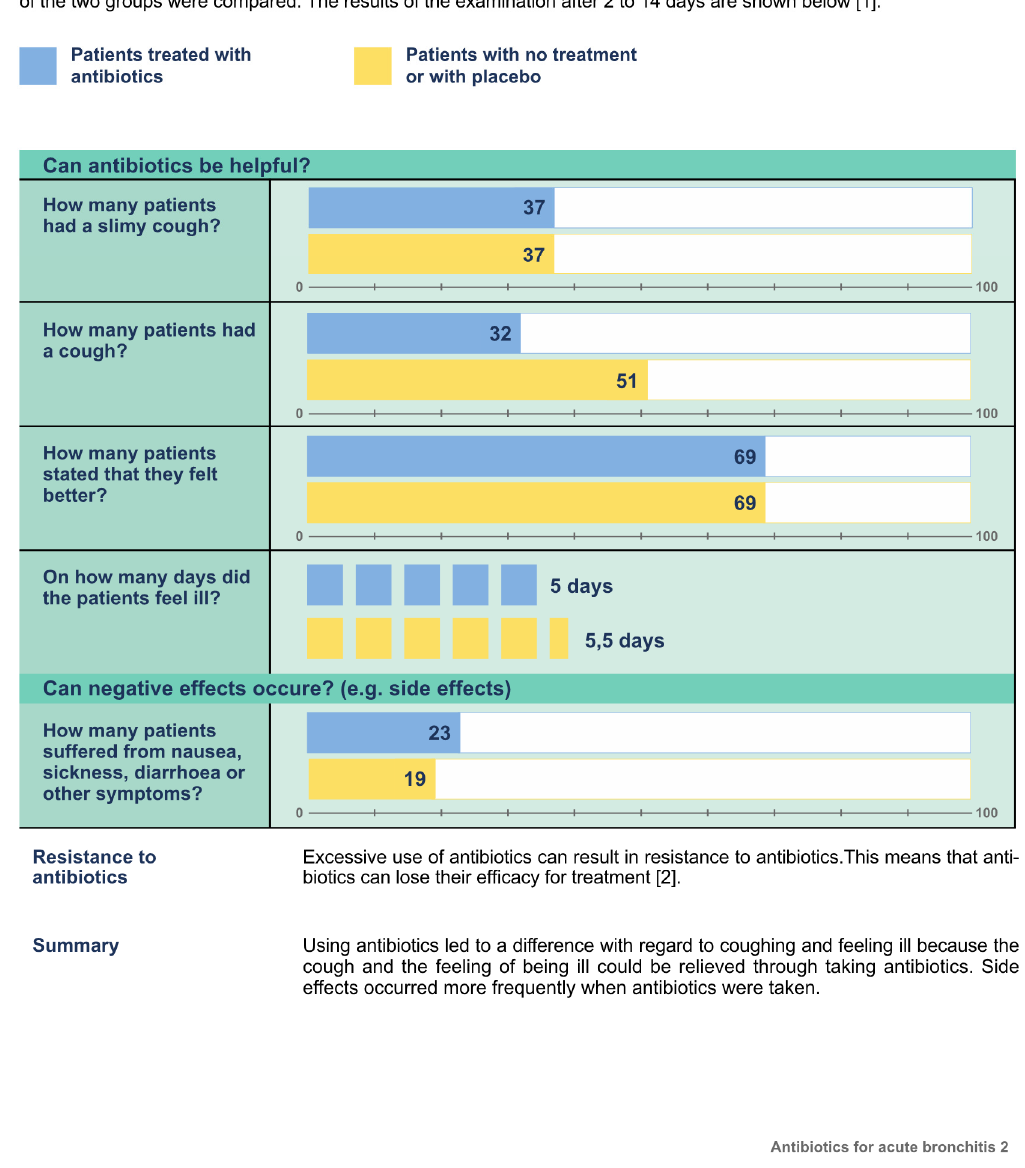
Figure 3. The fact box that presented treatment effects as a graphical presentation.